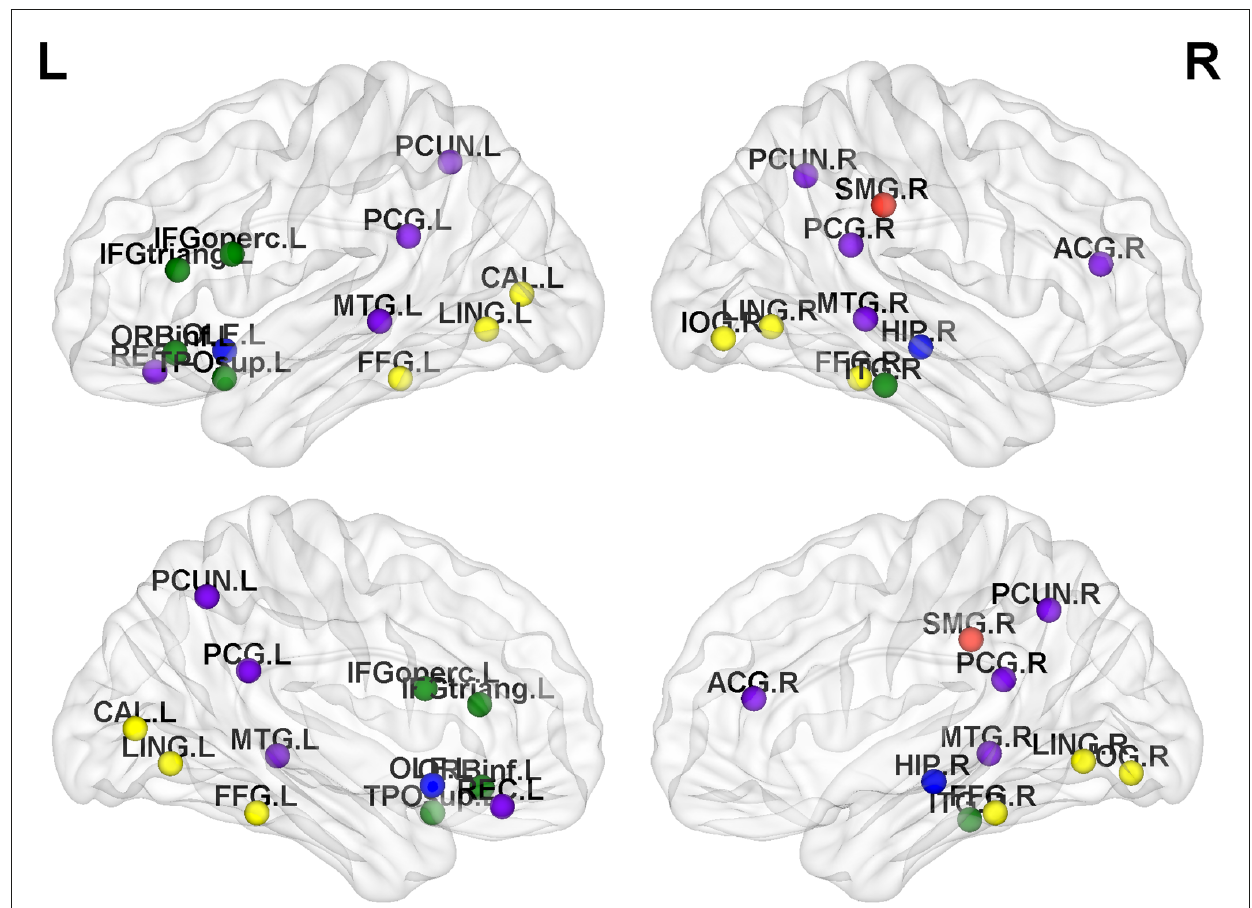
FIGURE4 Distribution map of abnormal brain regions with significant differences in metrics (recruitment, integration, flexibility or promiscuity). Among them, the red nodes belong to the sensorimotor network, the yellow nodes belong to the VN, the green nodes belong to the AN, the blue nodes belong to the subcortical region, and the purple nodes belong to the